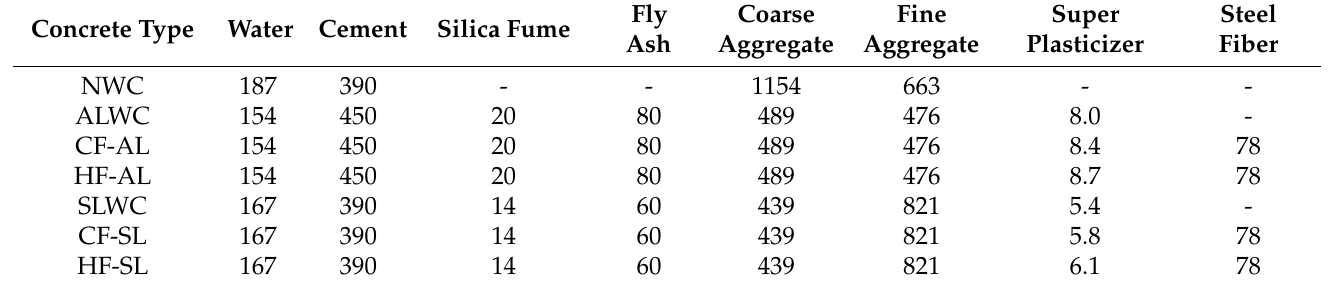
Table 4. Mixing proportions of the different mixtures (kg/m 3